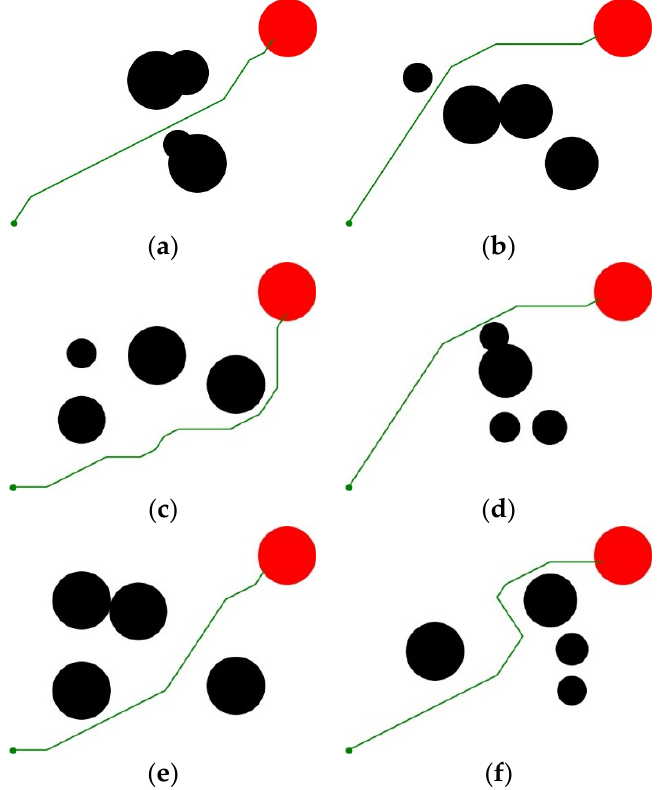
Figure 10. The global path planning results of the proposed method. ( a ) Result 1, ( b ) Result 2, ( c ) Result 3, ( d ) Result 4, ( e ) Result 5, ( f ) Result 6.